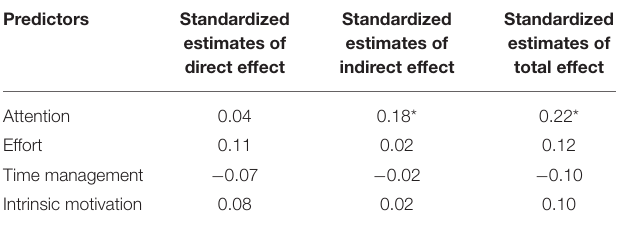
TABLE 4 | Standardized indirect effects on intention to use digital learning materials for